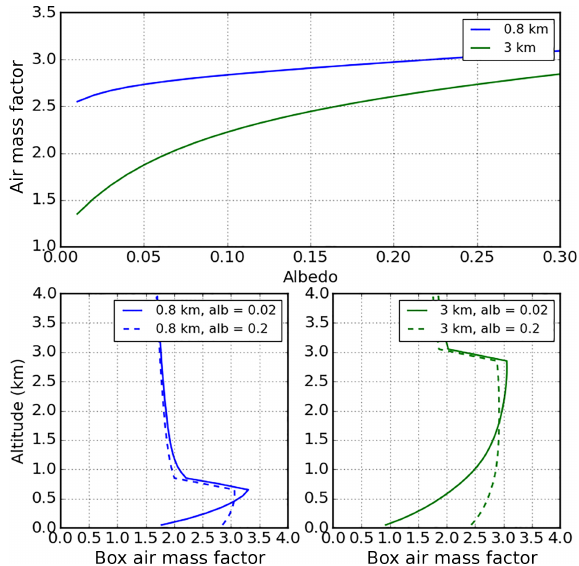
Figure 10. Calculated nadir air mass factors in the AROMAT con- ditions, respectively from 800m altitude and 3km